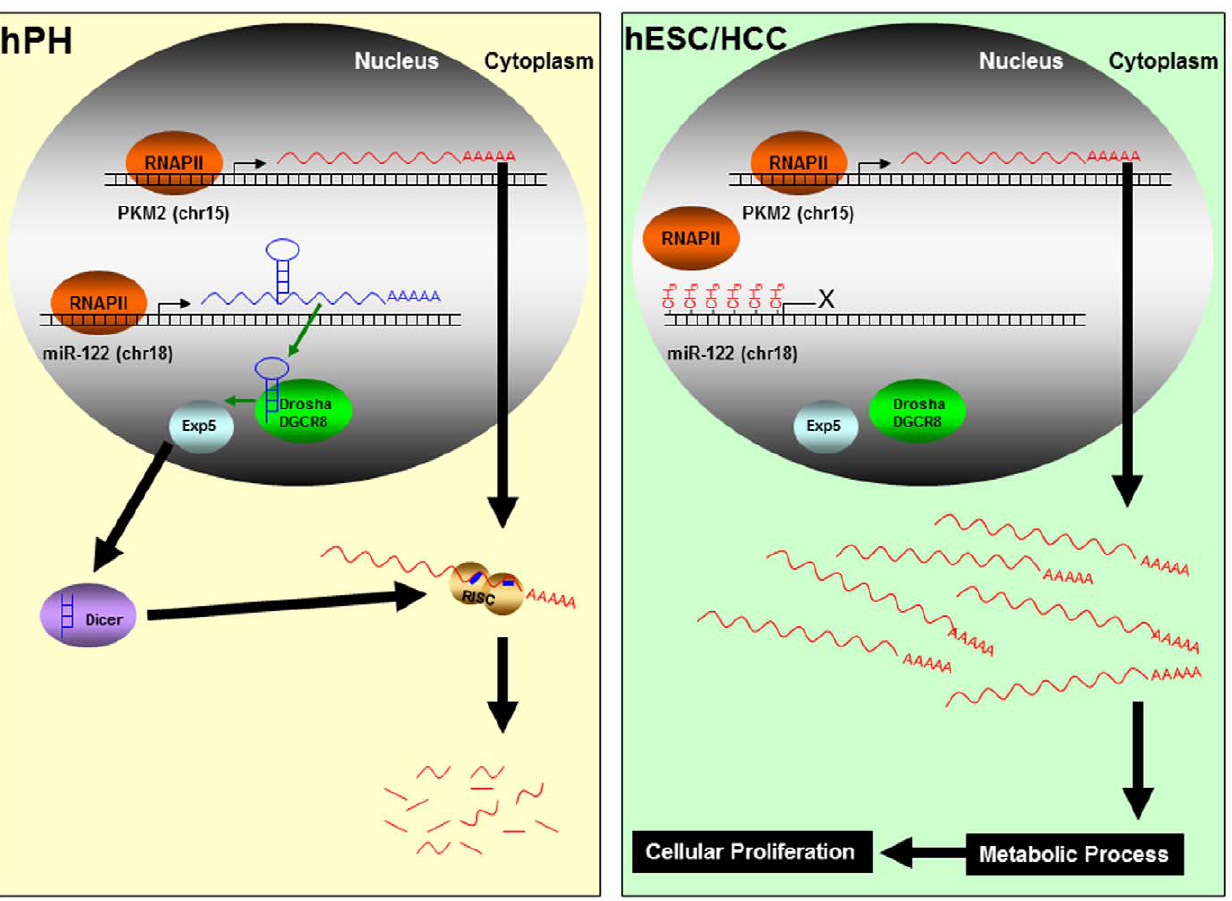
Figure 9. A model for miR-122 regulation of Pkm2 . In hESCs and HCCs, hyper-methylation of the genomic region up-stream of miR-122 inhibits transcription. In hPHs, an absence of methylation allows the binding of RNAPII and initiation of miR-122 transcription.